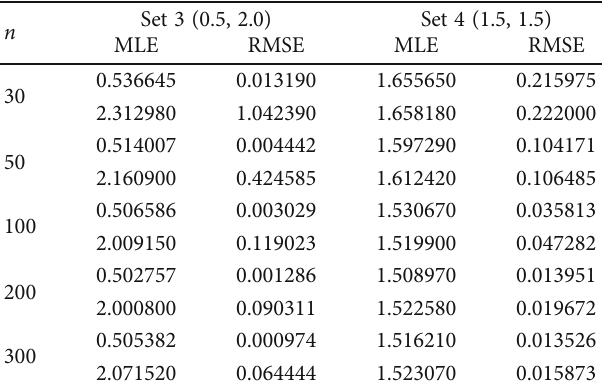
Table 8: MLEs and MSE of DWQL distribution for set 3 and set 4 : n Set 3 (0.5, 2.0)